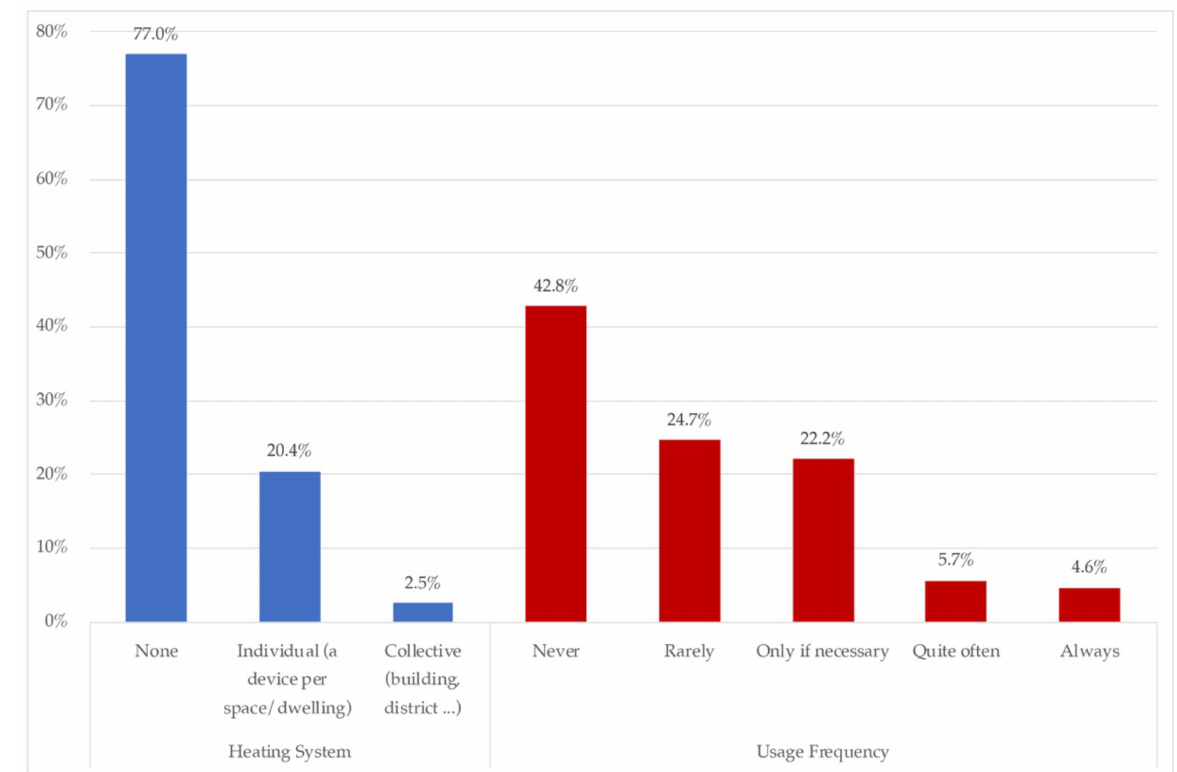
Figure 6. Availability and frequency of use of the heating system.